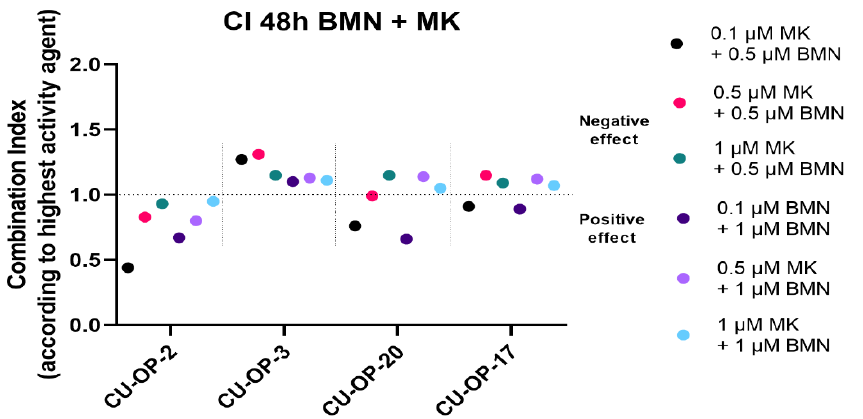
Figure 6. Combinational effects of PARP inhibitor BMN-673 and WEE1 inhibitor MK-1775 after 48 h. Combination indexes (CIs) were shown with the highest single agent approach after 48 h, where CI > 1 shows a negative combination effect and CI < 1 shows a positive combination effect. CIs were calculated from the mean of three experiments analyzed by WST-1, at 48 h after treatment. CI denotes combinational index; BMN denotes BMN-673 and MK denotes MK-1775.